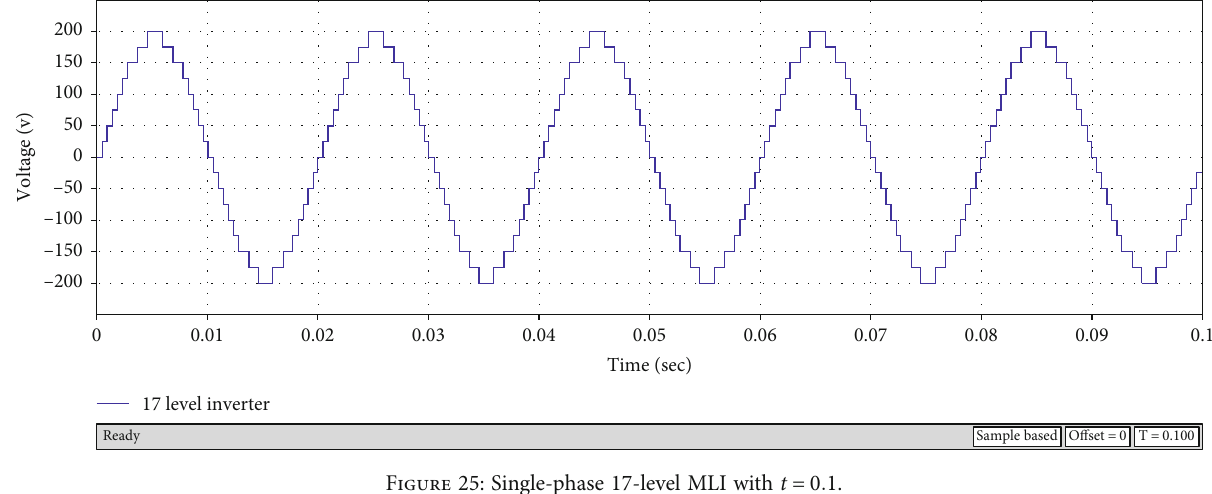
Figure 25: Single-phase 17-level MLI with t = 0 : 1 .